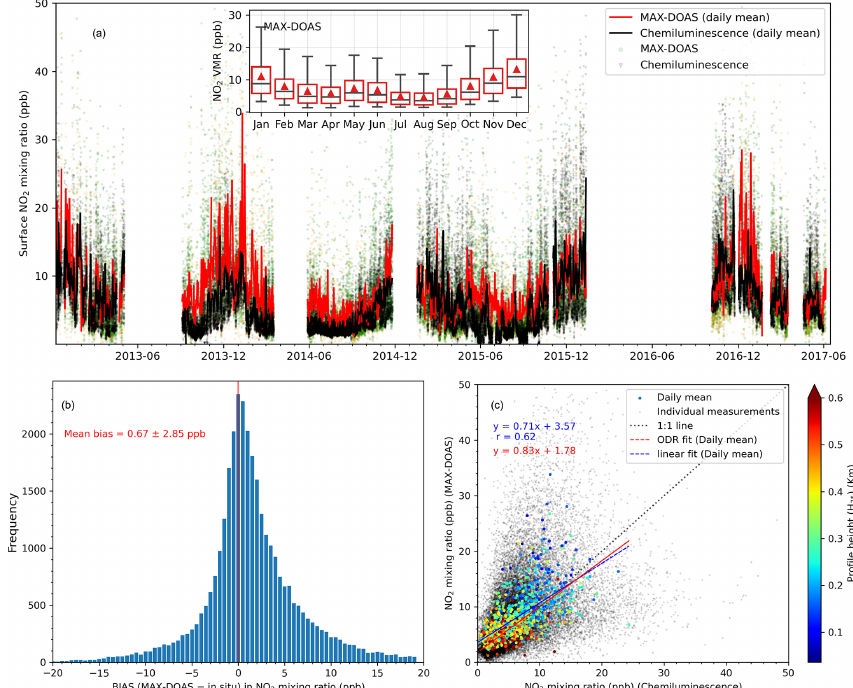
Figure 12. (a) Daily mean NO 2 mixing ratios measured using an in situ chemiluminescence analyser (black line) and average mixing ratio in the lowest layer (0–200m) retrieved by the profile inversion of MAX-DOAS measurements (red line). The green and orange dots in the background show the mixing ratios corresponding to the individual MAX-DOAS elevation sequences flagged as valid and warning, respectively. The inset of (a) shows the monthly variability of the MAX-DOAS surface NO 2 VMR as a box-and-whiskers plot; (b) shows the frequency distribution of the BIAS (MAX-DOAS – in situ) for the individual surface VMR measurements; (c) shows the scatter plot between the daily mean surface NO 2 VMR from MAX-DOAS and an in situ analyser colour-coded according to the profile height ( H 75 ). The individual measurements are shown as black dots in the background of (c)